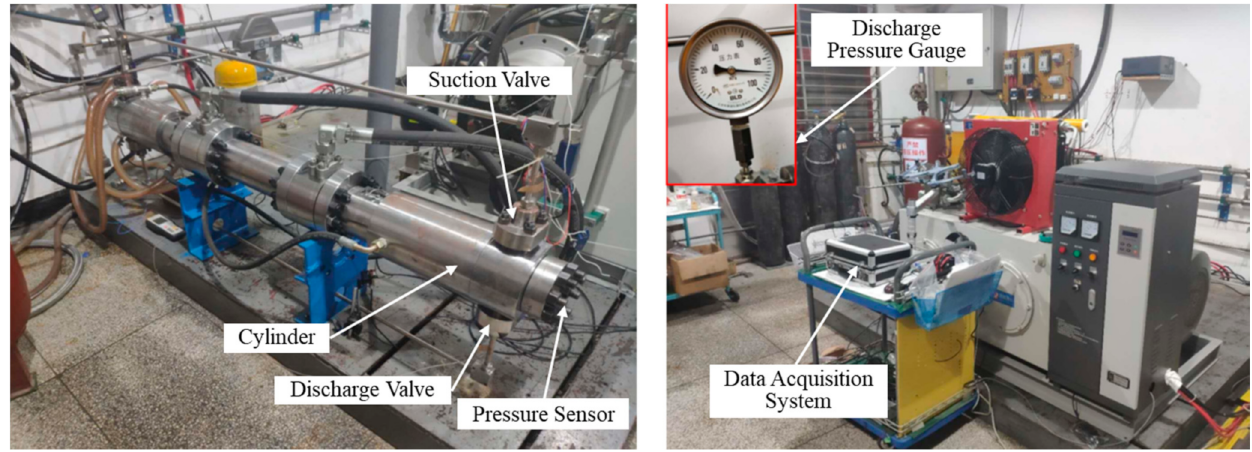
Figure 20. Hydraulically driven piston